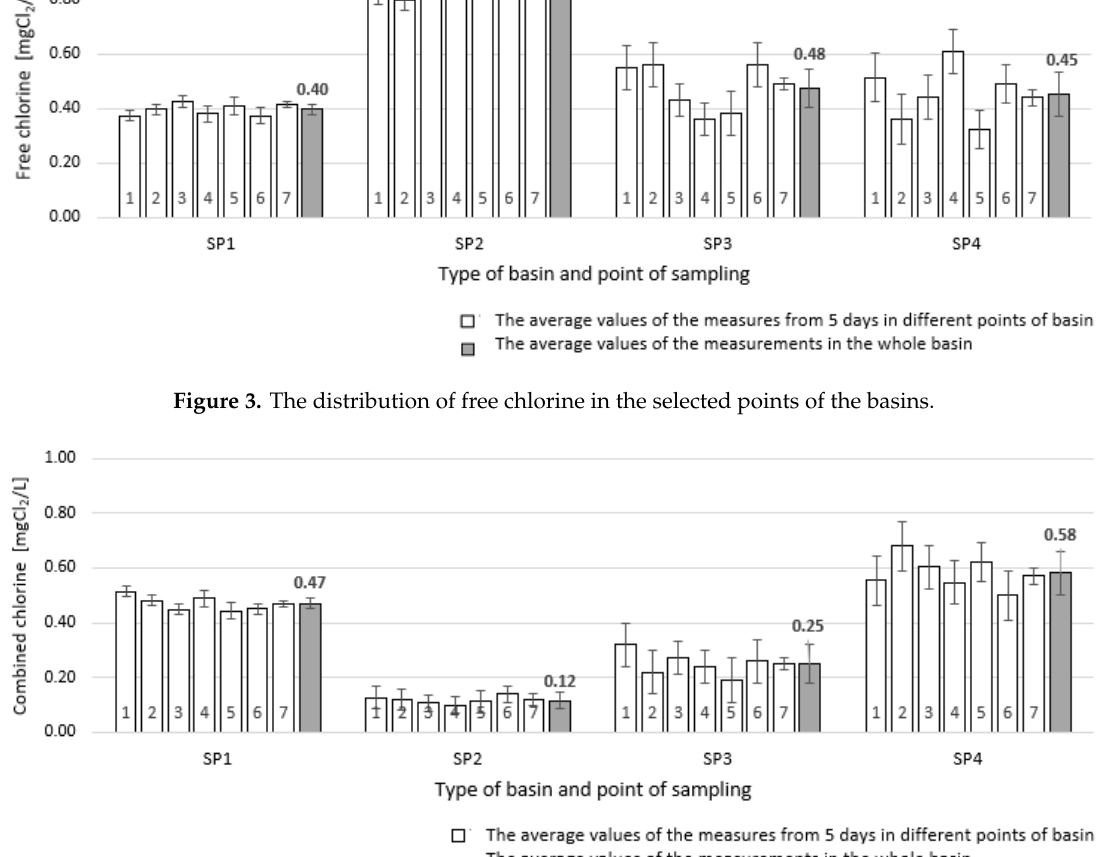
Figure 5. The correlation between the content of free and combined chlorine in tested pools. The daily variability of free and combined chlorine content is presented in Figures 6 and 7, respectively. The presented results are the average values of the measurements from different points of sampling, collected every day of the study. The average free chlorine content meets the requirements (0.3–0.6 mg Cl 2 /L) in the indoor pools (SP1, SP3 and SP4), but exceeds them considerably in the outdoor pool (SP2). The specificity of the outdoor swimming pool compared to the indoor swimming pools (the greater load of swimmers, the more intense sunlight on the surface of the water, greater exposure to contaminants from the pool beach and cosmetics) resulted in higher